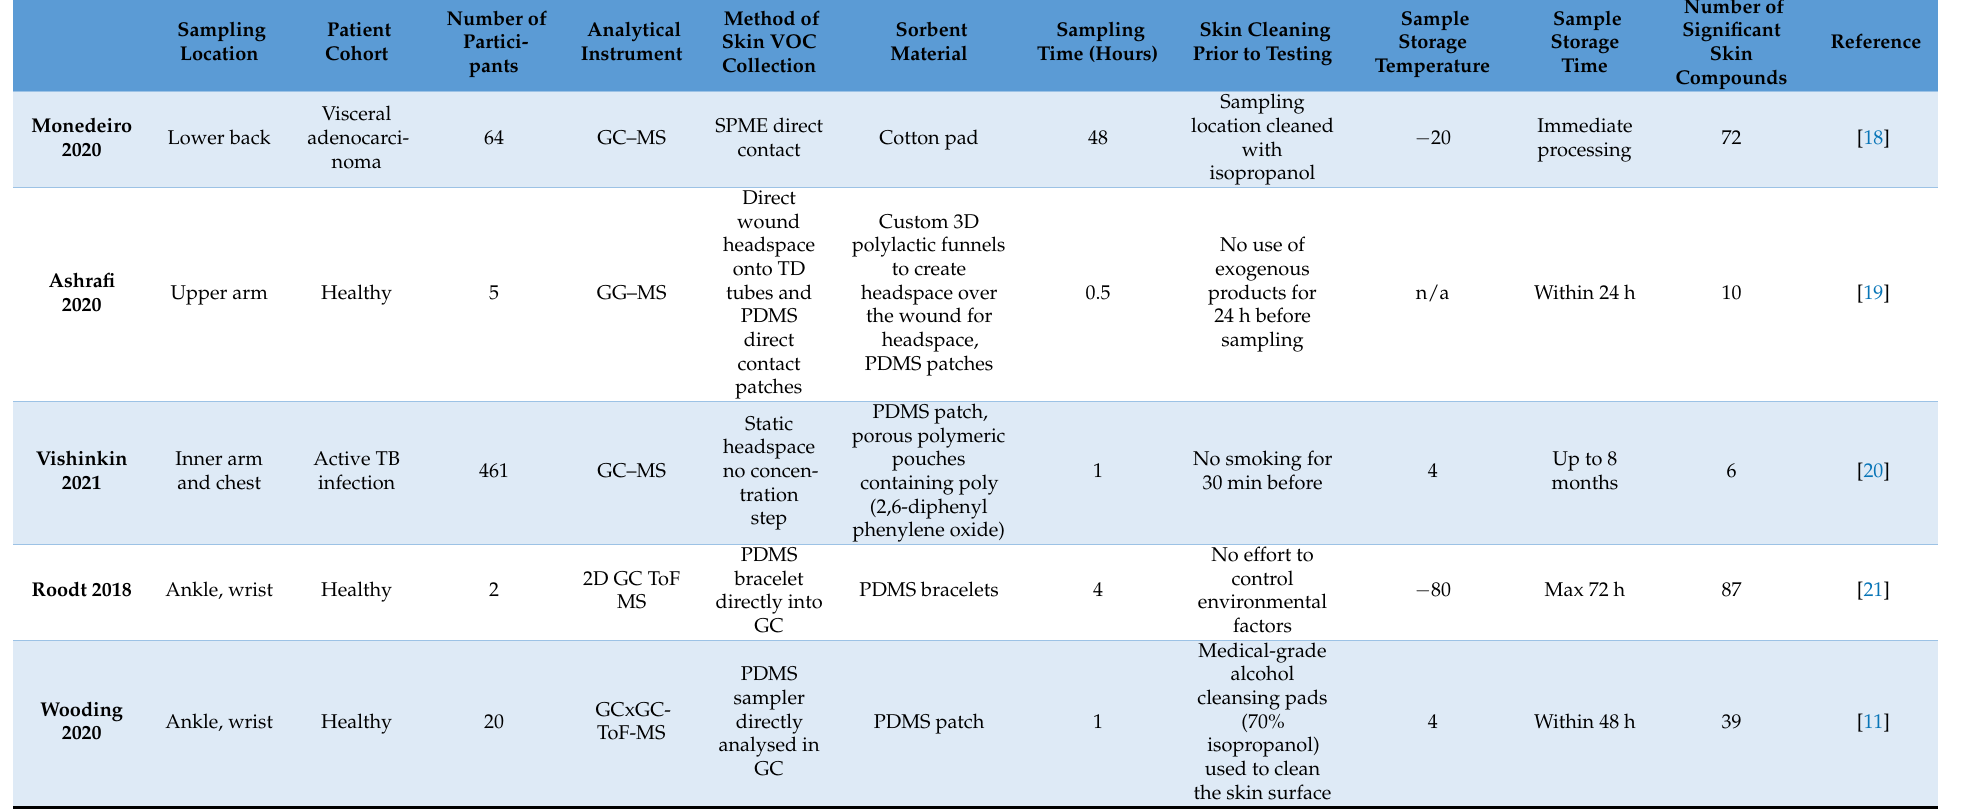
Table 1. Study characteristics, methods of skin volatile organic compound (VOC) sampling, and analytical platform